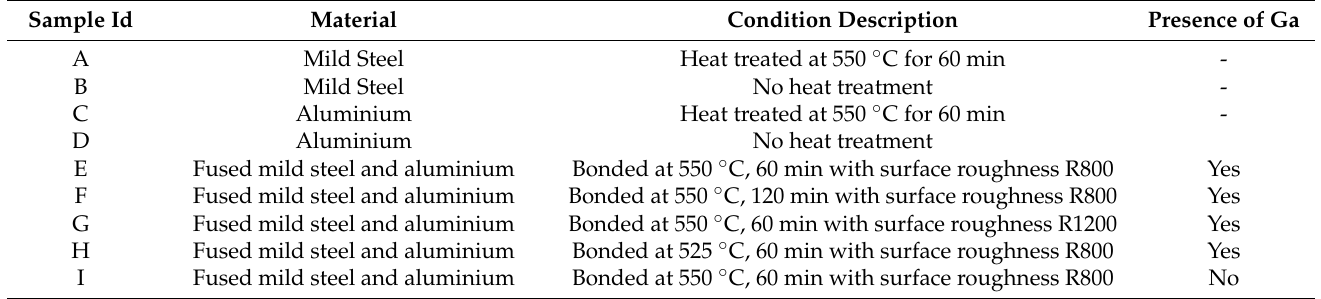
Table 2. Sample description for the BMs and fused metal joints.